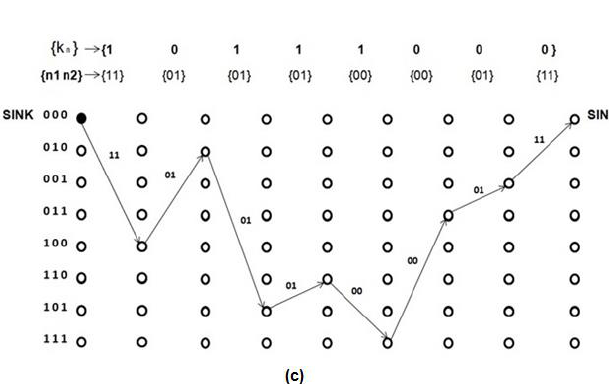
Figure 7. (a) Mealey machine (MM) with k/n=1/2, resulting output words (n1, n2); (b) Trellis diagram corresponding to MM; (c) Theoretical result of the route over the trellis due to a